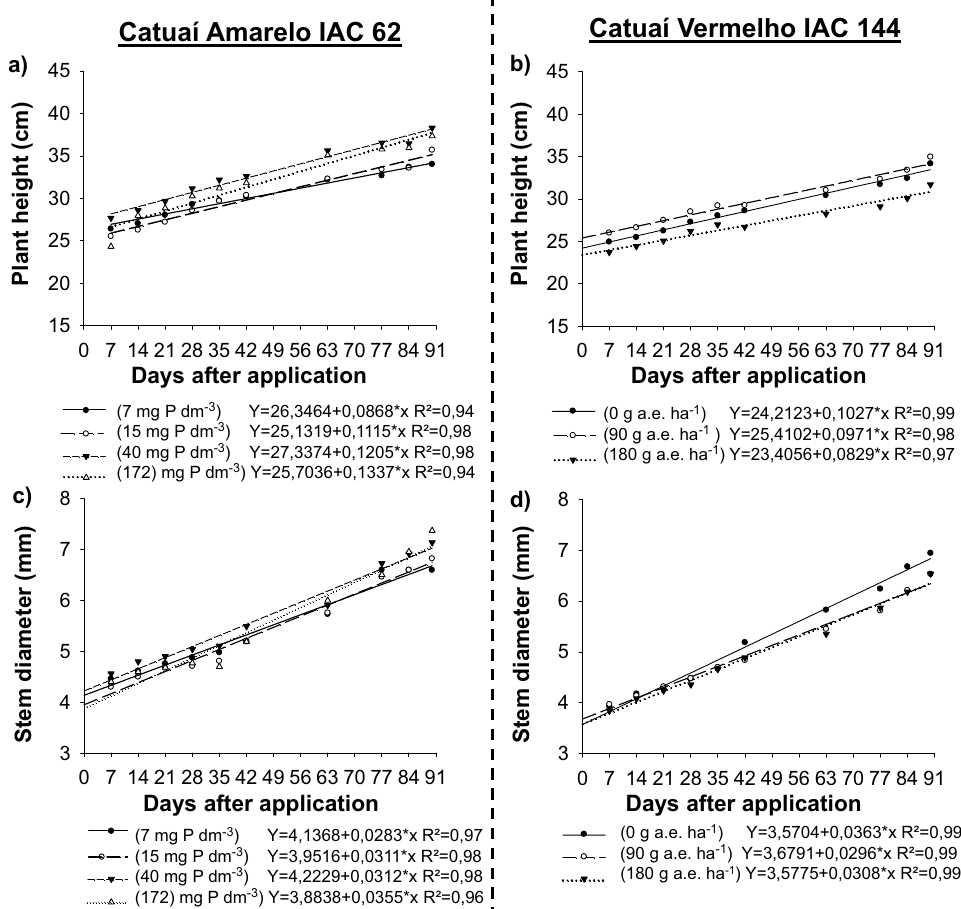
Figure 1. Plant height (cm) ( a , b ) and stem diameter (mm) ( c , d ) of the arabica coffee cultivars Catuaí-Amarelo/ IAC-62 and Catuaí-Vermelho/IAC-144 cultivated in soils with different content of P (mg dm −3 ) and subjected to subdoses of glyphosate in relation to the days after the application of glyphosate. Plots were drawn using SigmaPlot ver. 10.0 (Systat Software, Inc., San Jose, USA, www. systa tsoft ware.